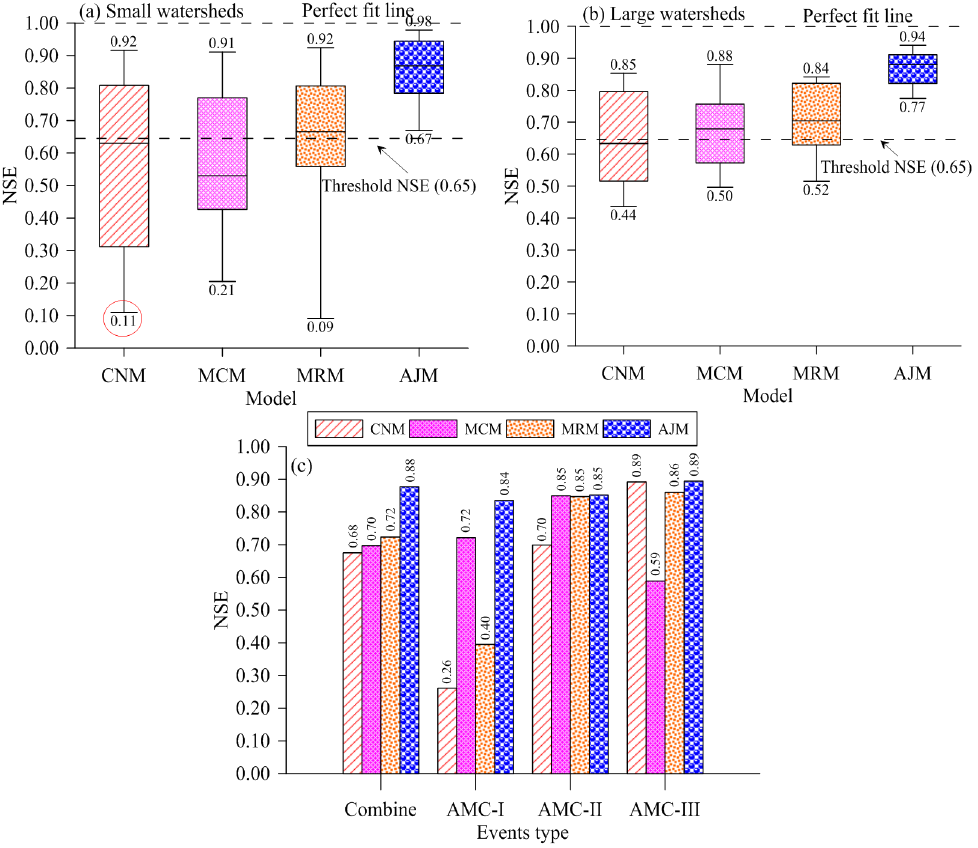
Figure 4. Model performance based on Nash-Sutcliffe efficiency (NSE) ( a ) in small watersheds (Area ≤ 250 km 2 ); ( b ) in larger watersheds (Area > 250 km 2 ) and ( c ) for different types of events (dry, normal and wet). The circled NSE value for the CNM shows the second overall value (the minimum was − 0.05, which is not shown here).